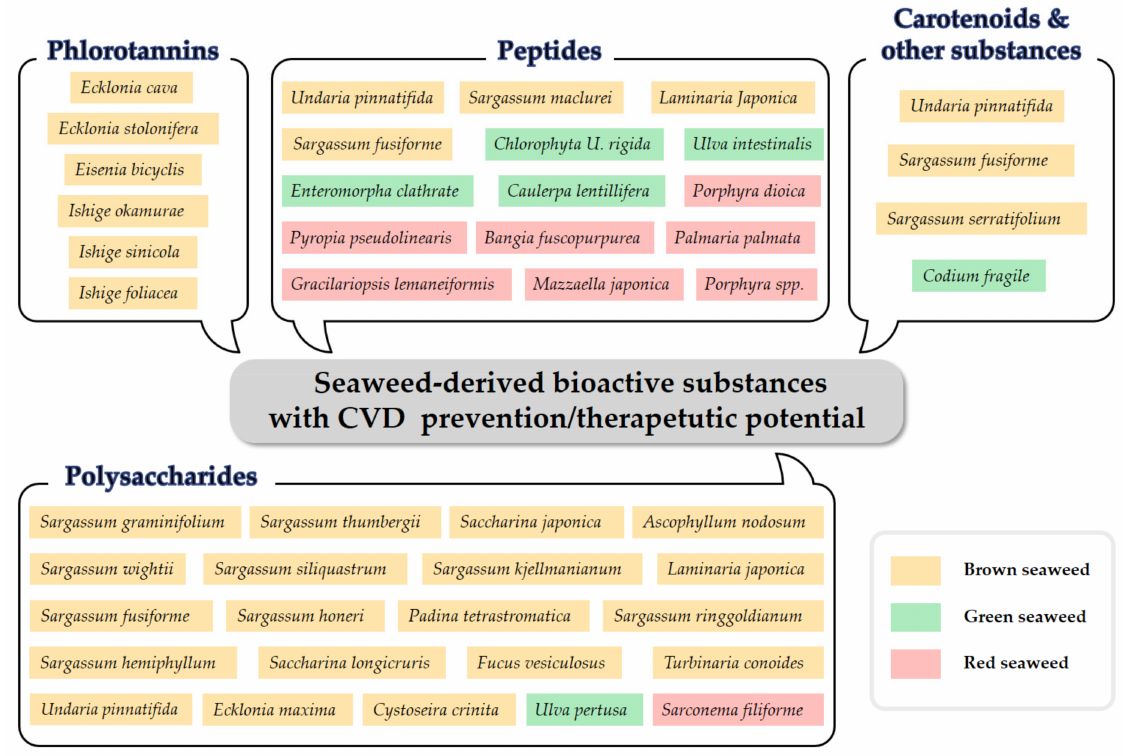
Figure 1. The preventive potential of various seaweed-derived natural components associated with cardiovascular disease (CVD) pathogenesis, such as diabetes mellitus, obesity, hypertension, and